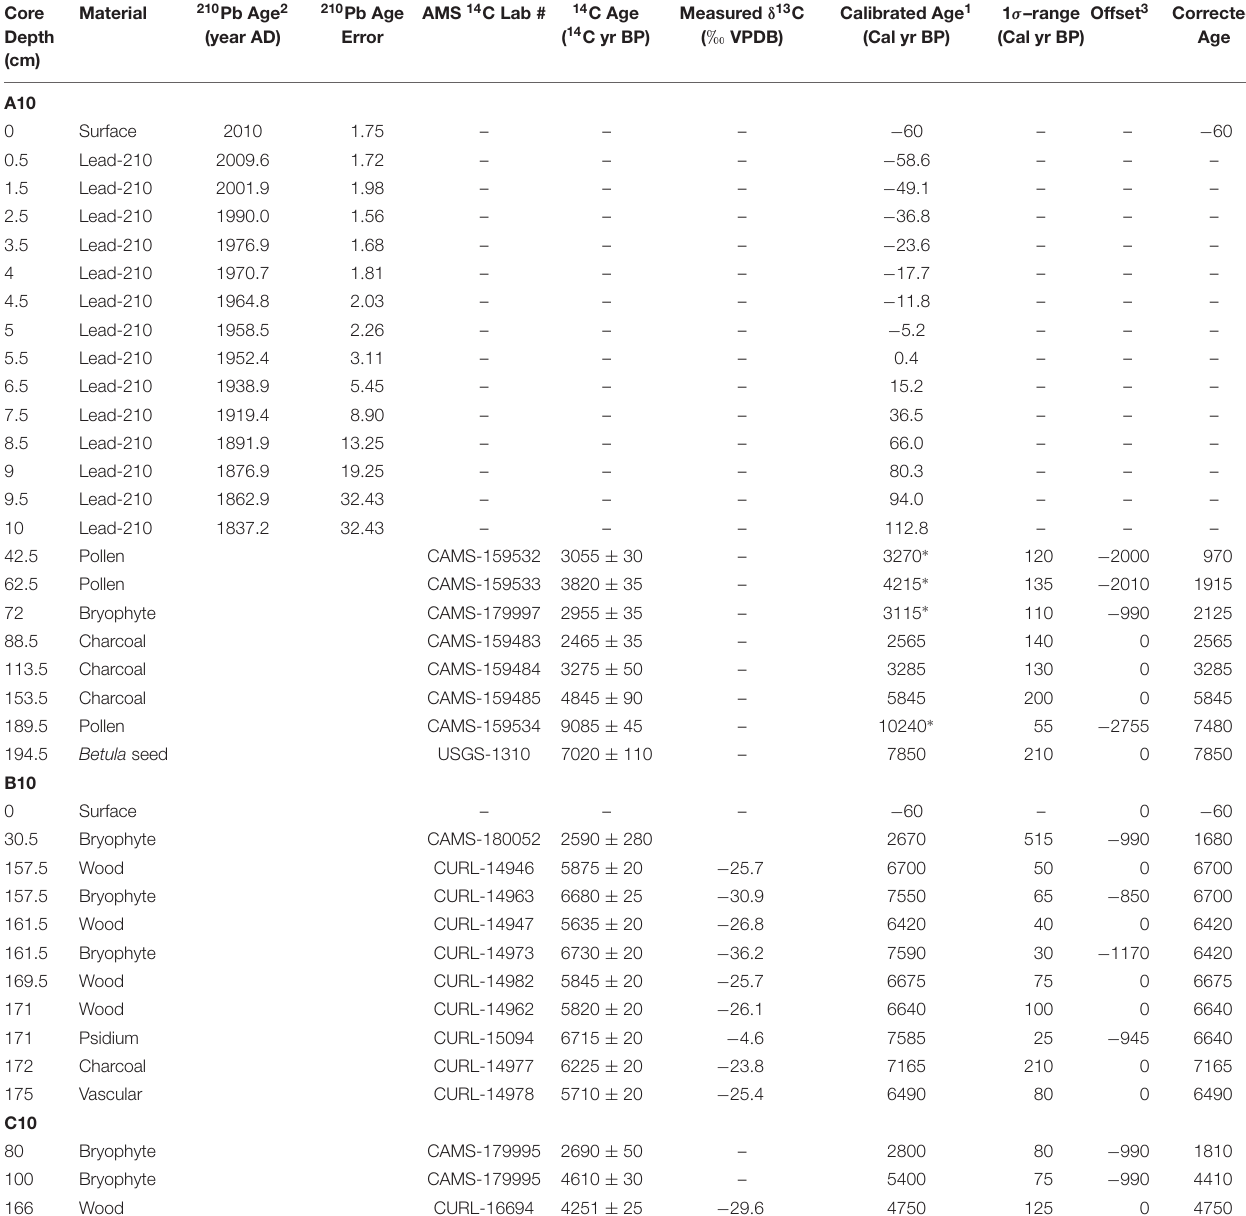
TABLE 3 | Greenpepper lake chronostratigraphic